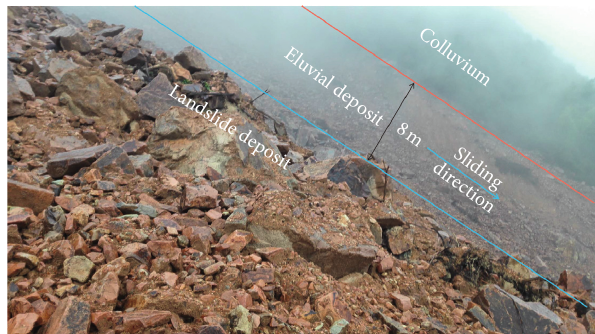
Figure 2: Postlandslide accumulation in the middle part of the slope (this photo was taken at 9:15 am, 30 September 2016, two days after this rockslide occurred, when the upper part of the landslide was covered by cloud).